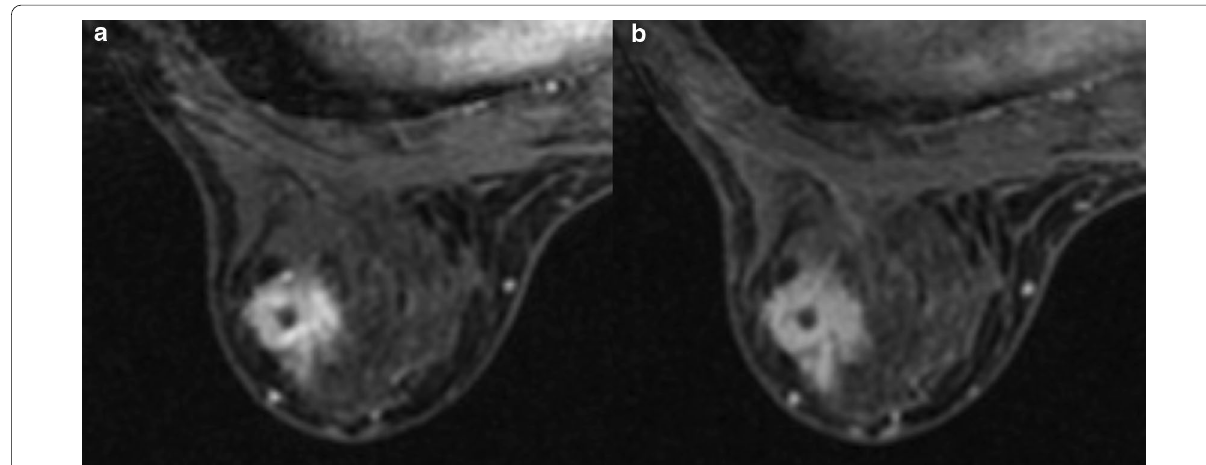
Fig. 3 Magnetic resonance imaging. a A 1.9 well imaged in the early phase. b The tumor was washed out in the late